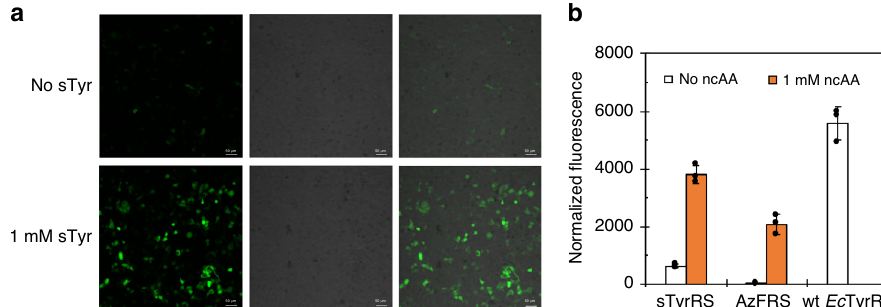
Fig. 2 Evaluation of sTyrRS in mammalian cells. a Confocal images of 293T cells expressing the evolved sTyrRS and an EGFP mutant that contained an amber mutation at position Tyr40. The left panel shows fl uorescent images, the middle panel shows bright fi eld images, and the right panel shows composite images of bright- fi eld and fl uorescent images. Scale bars, 50 μ m. b Flow cytometry analyses of 293T cells expressing the evolved sTyrRS, AzFRS, and wild-type Ec TyrRS, each with the EGFP-Y40TAG mutant. The normalized fl uorescence was calculated by multiplying the mean fl uorescence intensity by the percentage of fl uorescent cells in fl ow cytometry analyses in the absence (open bar) or presence ( fi lled orange bar) of ncAA. b Data are plotted as the mean ± s.d. from n = 3 independent experiments. The raw data of fl ow cytometry experiments are shown in Supplementary Fig. 2. b Source data are provided as a Source data fi le.